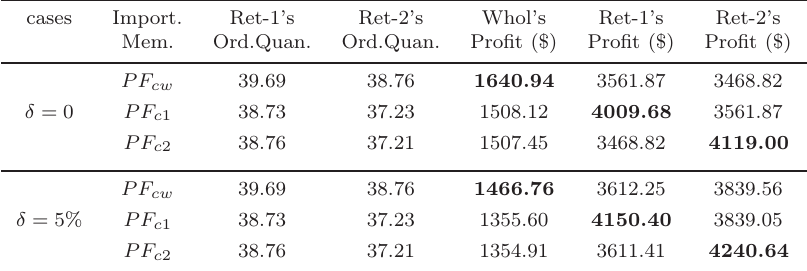
Table 5. Optimal results with priority (importance) to different objective